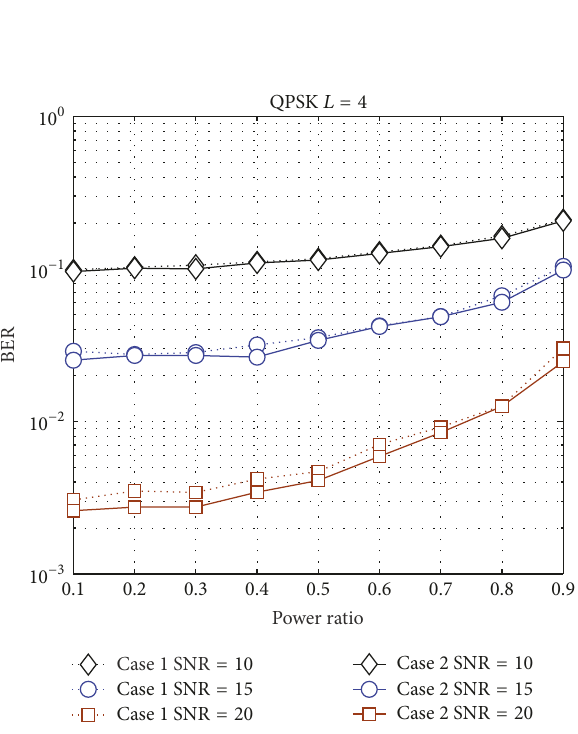
Figure 5: BER versus 훾 for different SNR conditions.